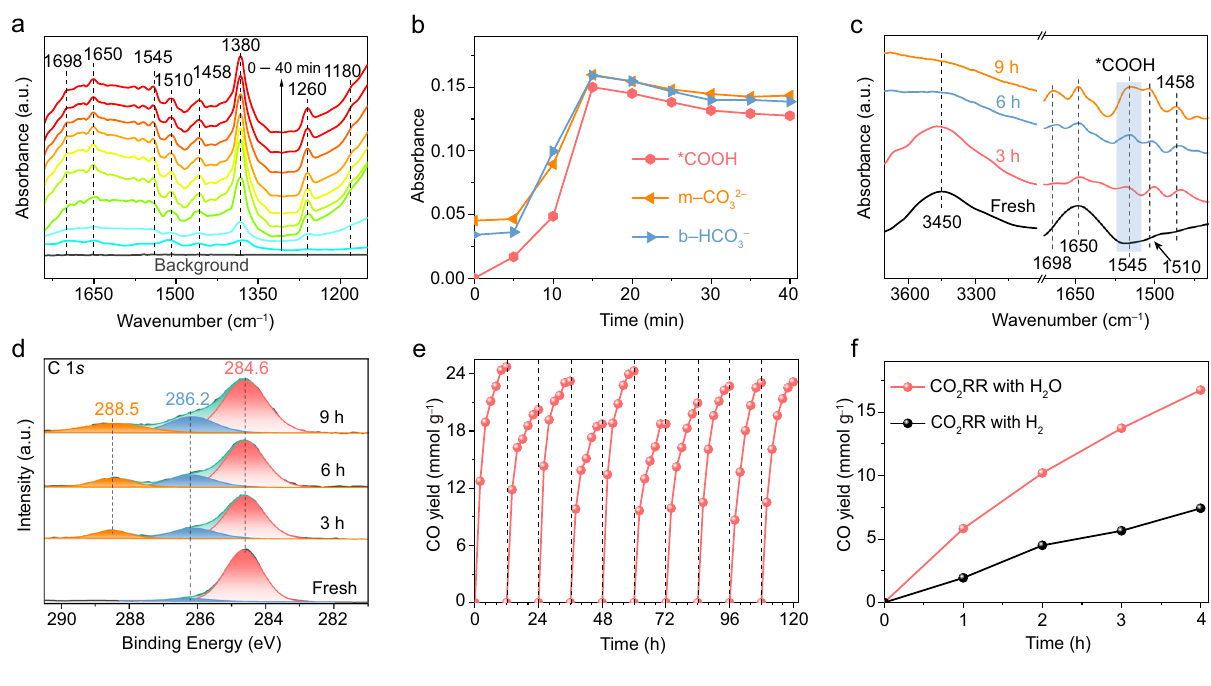
Fig. 3 Characterization of the formed species during CO 2 RR and the enhanced CO 2 RR performance in H 2 O compared with that in H 2 . a In situ FT-IR spectra of the photocatalytic CO 2 reduction process occurring with H 2 O on Au. FT-IR spectra were recorded every 5 min from bottom to top. b Absorbance of the intermediate species that formed on Au during the photocatalytic CO 2 RR. c FT-IR and d high-resolution C 1 s XPS spectra at photocatalytic reaction times of 0 (fresh), 3, 6, and 9 h. e Stability test for Au NPs under 420 nm illumination for CO 2 RR at 200 °C. f Photocatalytic CO 2 RR performance on Au NPs with H 2 O or H 2 under 420 nm light illumination at 200 °C. The volume ratio of H 2 to CO 2 is 4:1 in the gas